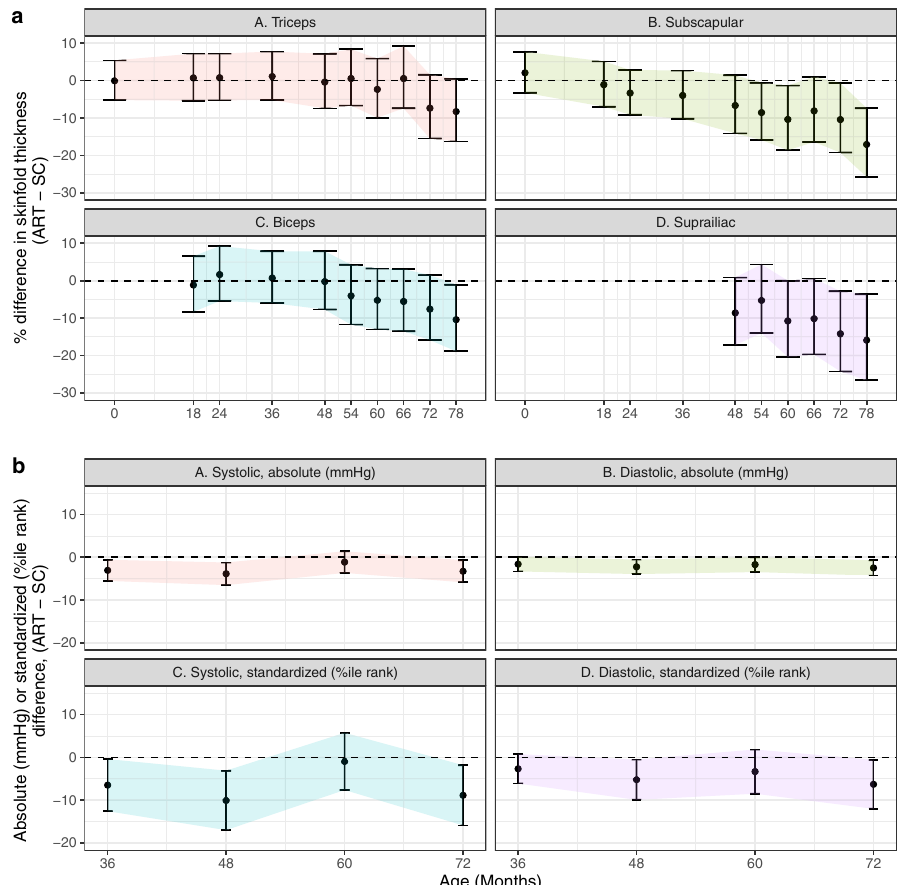
Fig. 2 Associations between ART status and skinfold thickness and blood pressure, adjusted for pre-pregnancy characteristics. Point estimates and Wald-type 95% con fi dence intervals show the adjusted mean difference in skinfold thickness ( a ) and blood pressure ( b ) measures between ART- conceived and spontaneously conceived (SC) children at each study visit, with SC children as the referent. Differences were estimated by multivariable linear regressions adjusted for maternal age, education, ethnicity, household income, height, pre-pregnancy BMI, parity, and any tobacco exposure in the home; paternal age, height, weight, diabetes history, and high blood pressure history; child size, and polygenic risk score for adult adiposity with no multiple testing adjustments. Multiple imputations by chained equations were used to estimate associations while simultaneously accounting for missing covariate values. Skinfold sample sizes ( a ) for each visit (SC/ART): 1038/81; 762/48; 776/54; 827/62; 765/55; 810/63; 779/59; 777/62; 750/55; 743/57. Blood pressure sample sizes ( b ) for each visit (SC/ART): 716/53; 662/44; 701/48; 647/47. Note, not all measures were taken at each visit. Shaded regions connect con fi dence intervals to aid in visualizing trends and provide no additional information regarding estimates between visits. cm centimeters, m meters, kg kilograms, mmHg milimeters mercury, SDS standard deviation score; colors used to distinguish outcome